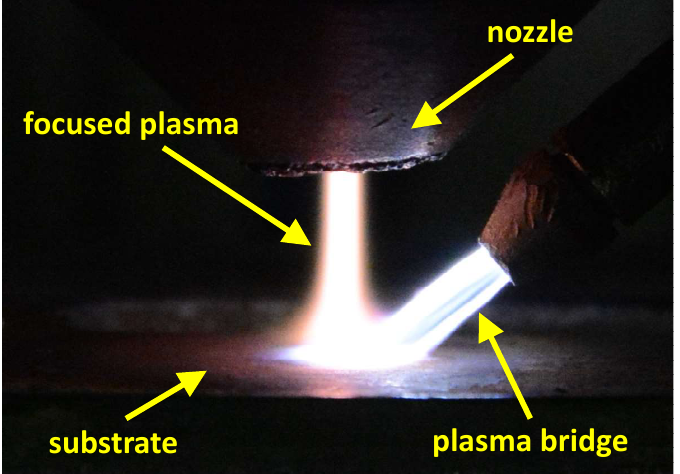
Figure 9. Picture of the focused plasma and plasma bridge grounding the substrate. Argon flow: 5 SLM, FG 95/5 flow: 60 SLM, power level: 100%, HV pulse frequency: 62 kHz, distance between the nozzle and the substrate: 6.5